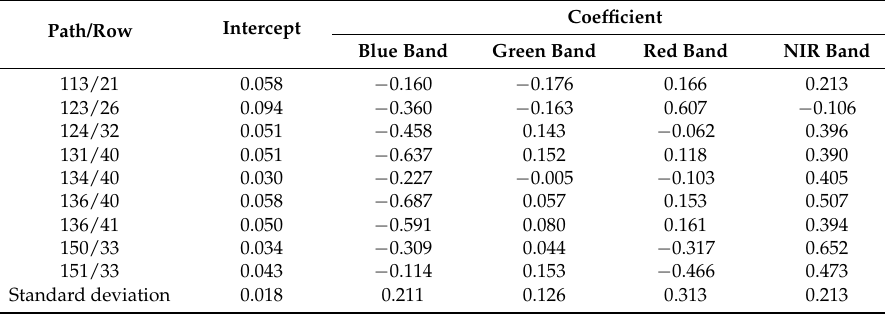
Table 2. The coefficients of multilinear regression per OLI image.